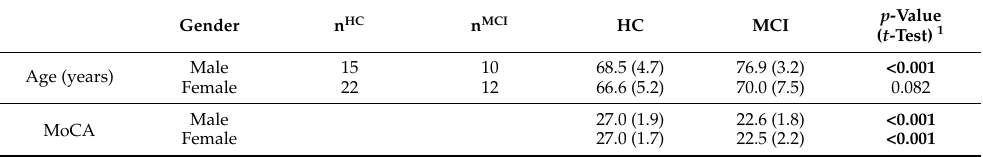
Table 1. Participant demographic